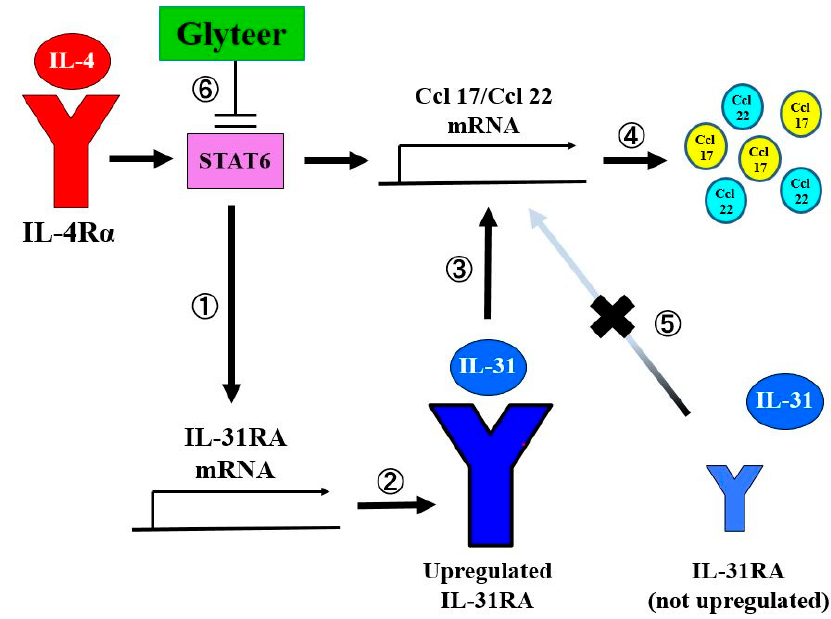
Figure 5. IL-4 augments IL-31/IL-31 RA interaction leading to enhanced Ccl 17 and Ccl 22 production in BMDCs. IL-4 induces upregulation of IL-31RA expression at the mRNA levels ① and the protein levels ② . IL-31RA expression initially upregulated by IL-4 stimulation can lead upregulation of Ccl 17 and Ccl 22 production at the mRNA levels ③ and the protein levels ④ , whereas IL-31 stimulation alone without IL-31RA upregulation did not upregulate Ccl 17 and Ccl 22 production ⑤ . Impairment of STAT6 signaling pathway activation by Glyteer ⑥ inhibits upregulation of IL-31RA expression and Ccl 17 and Ccl 22 production induced by IL-4 in BMDCs.